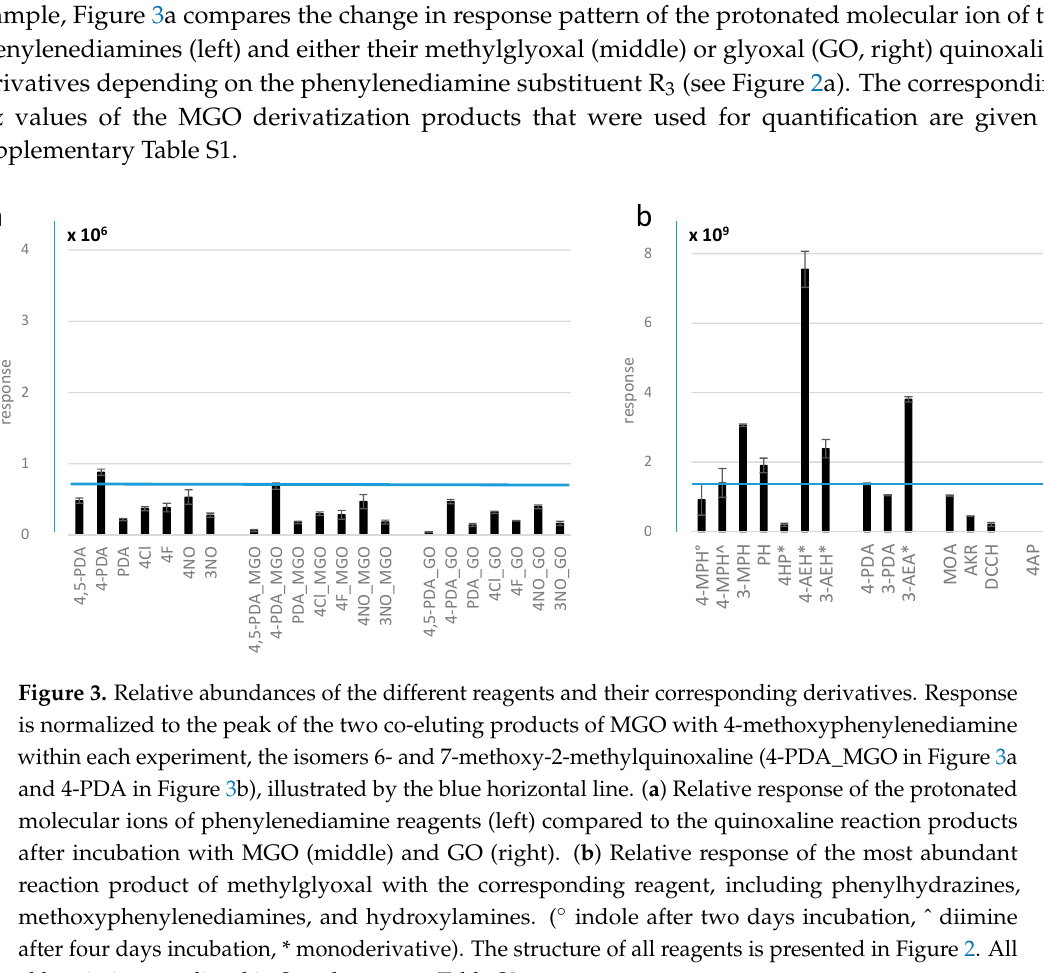
efficiency, the relative response of the reaction products may be caused by different reaction